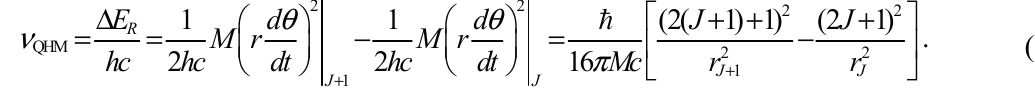
. (cid:2915)(cid:2934)(cid:2926)